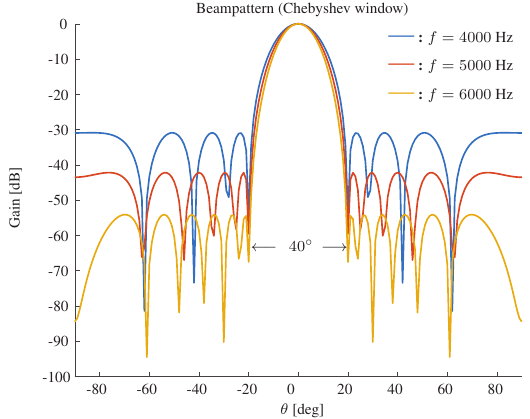
Figure 6. Constant beamwidth beampattern using the Chebyshev window. The beamwidth is fixed to 40 ◦ , M = 11, δ = 3.5